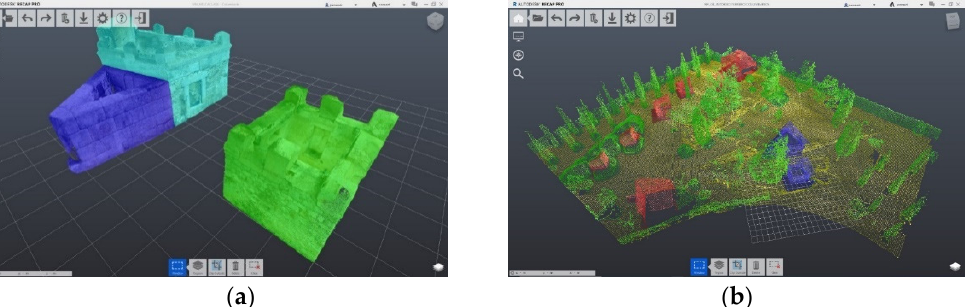
Figure 14. Results obtained from the classification of the point cloud made with Recap. We used a colour code that allowed for better visibility. ( a ) Screenshot of the processing and classification of the point cloud of the buildings with Recap. ( b ) Screenshot of the processing and classification of the topography point cloud with Recap.